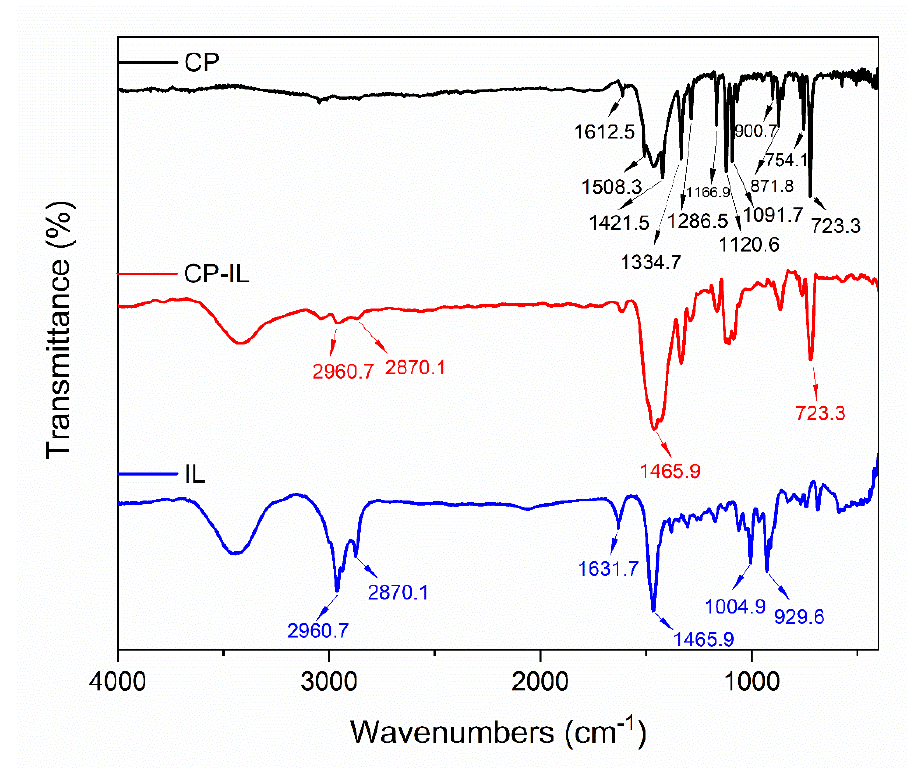
Figure 5. Fourier transform infrared (FT-IR) spectra of CP, CP-IL, and